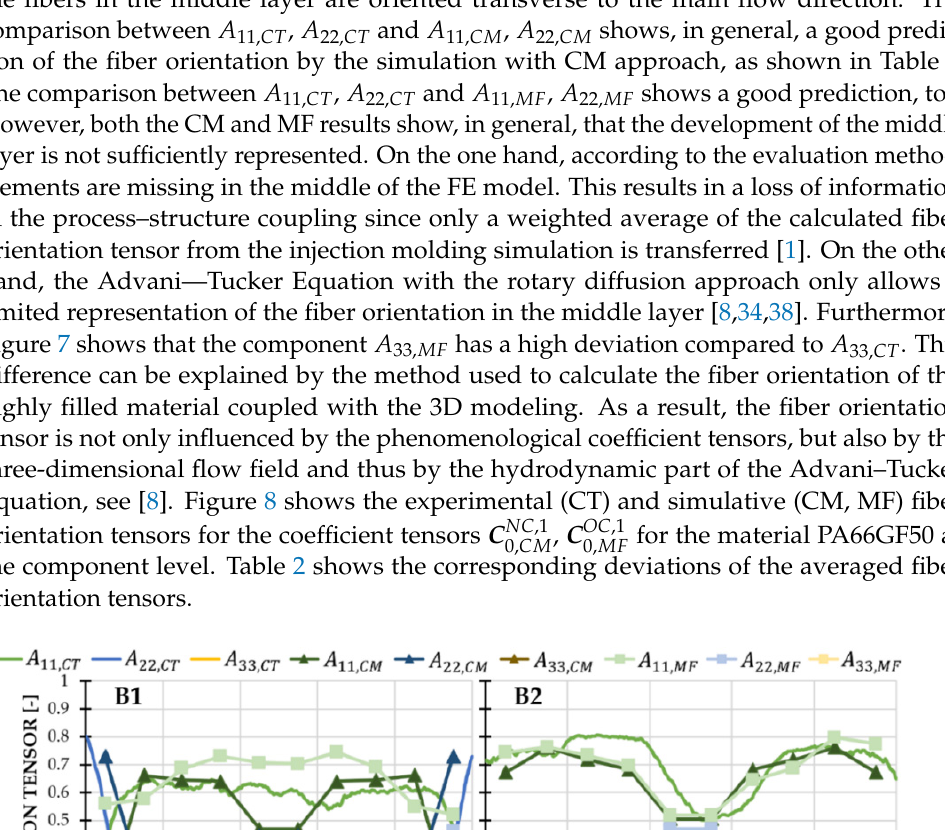
Table 1. Relative deviation of the averaged orientation tensors from experiment 𝐴 (cid:3036)(cid:3037),(cid:3004)(cid:3021) and simula- tion 𝐴 (cid:3036)(cid:3037),(cid:3004)(cid:3014) , 𝐴 (cid:3036)(cid:3037),(cid:3014)(cid:3007) of PA66GF50 on plate level (P1–P5).